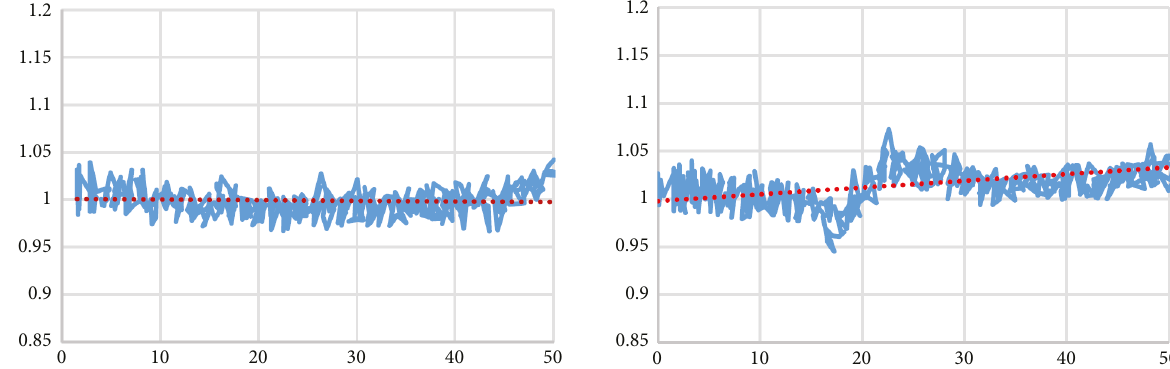
Figure 6: Dependence of the compensated accelerometerZ-axis values (1g – 9.81 m/s 2 ) upon the temperatureduring slow (1 ∘ C/min) heating (left) and cooling (right).